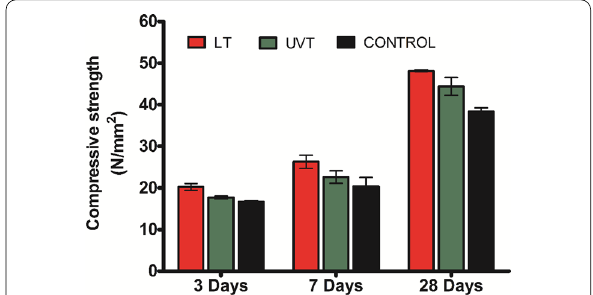
Fig. 5 Compressive strength of mortar specimens cured with live (LT) and UV treated (UVT) S. pevalekii cells at the age of 3-, 7-, and 28-day